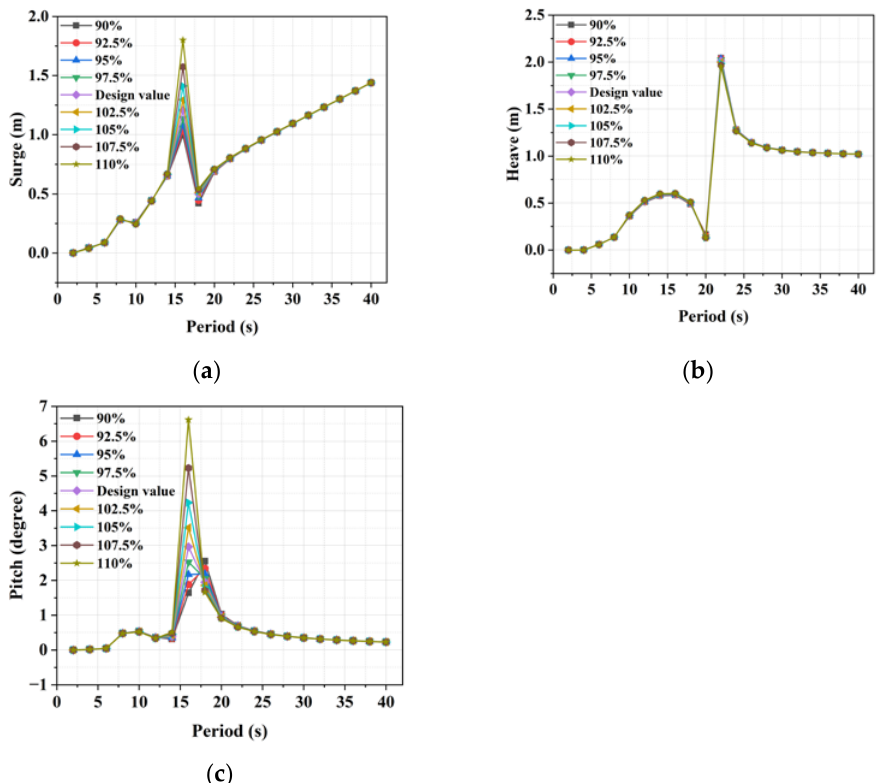
Figure 10. The motion transfer function of the optimized floating foundation with different column diameters: ( a ) Transfer function of surge motion; ( b ) transfer function of heave motion; ( c ) transfer function of pitch motion.